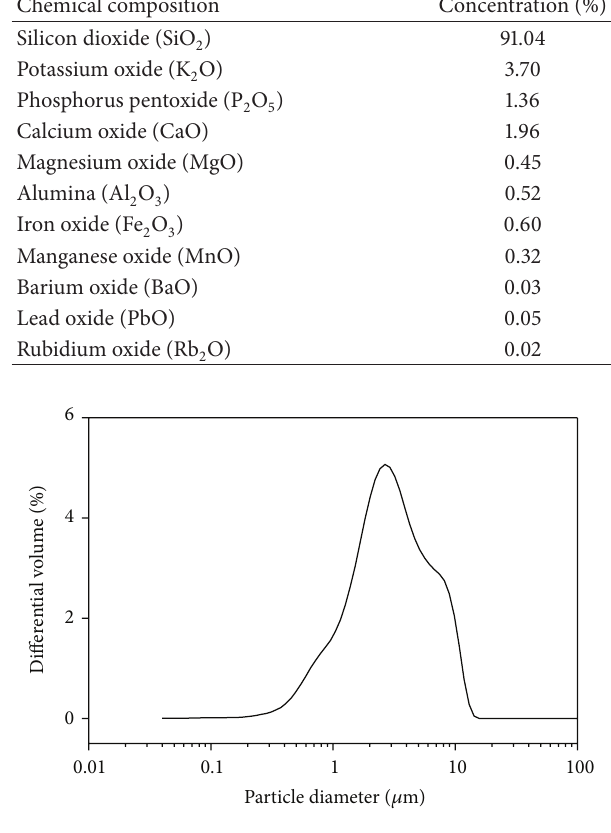
Figure 1: Particle size distribution curve of RHA.